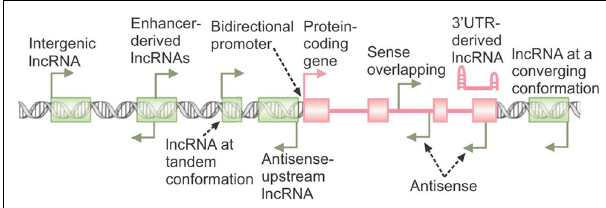
FIGURE 1 | The genomic origins of lncRNAs. The broken arrows indicate the location of transcription start sites and direction of transcription. The protein-coding gene is shown in pink, with green rectangles marking the loci of non-overlapping lncRNA genes. A 3 (cid:48) UTR-derived lncRNA originating from stabilization of degradation products of the protein-coding RNA is